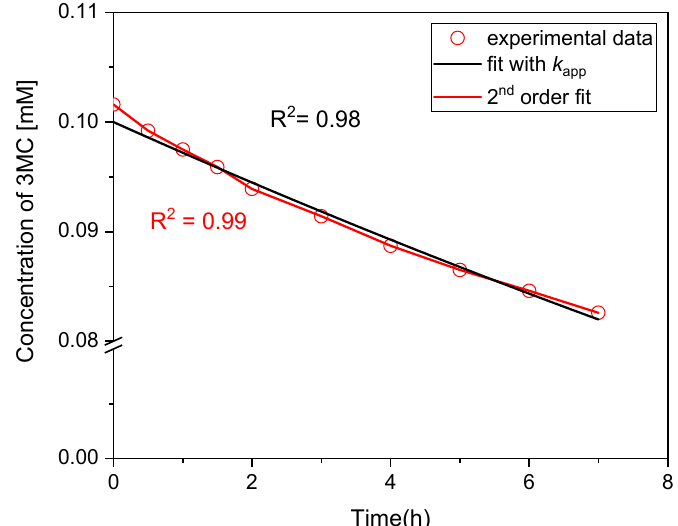
Figure 1. 3-methylcatechol (3MC) degradation in aqueous solution at 0.1 mM initial concentrations of 3MC and NaNO 2 (pH = 3.9, T = 25 ◦ C). Experimental data (symbols) and calculated time-dependent concentration profiles (lines) for the pseudo-first order ( k app ) and second order ( k 2nd ) kinetics.